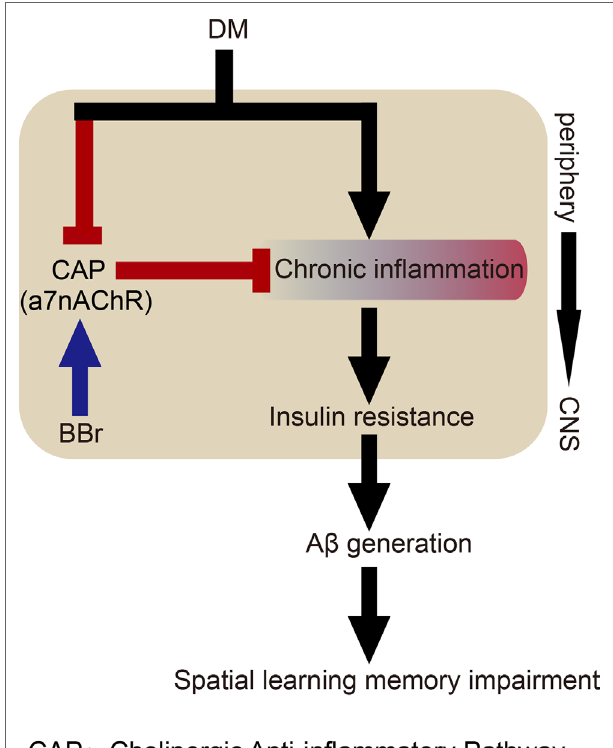
FIGURE 8 | Hypothetical mechanism of berberine to ameliorate impairment of spatial learning and memory in DM